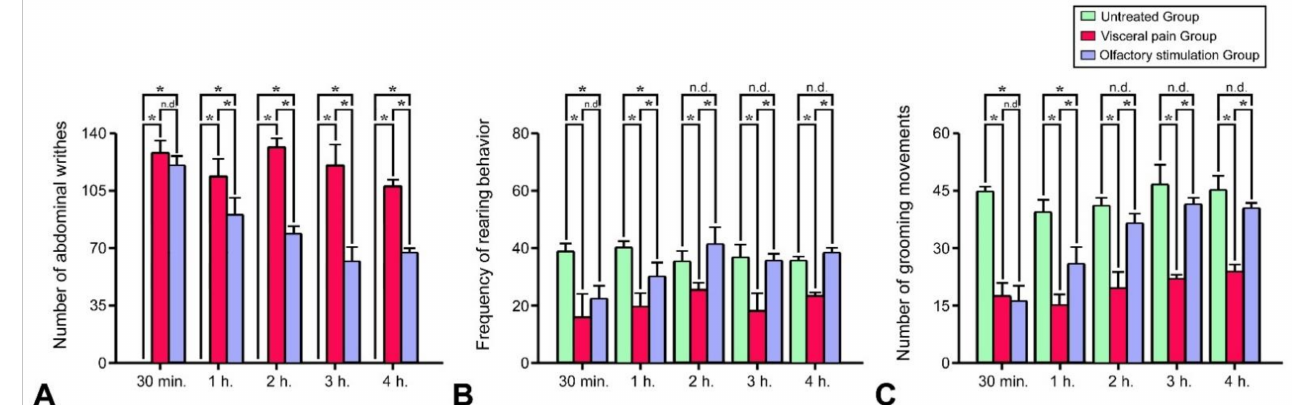
Figure 9. Histograms show the behavioral performances of the animals obtained from the untreated, visceral pain, and OS groups at several time points. Note that significant behavioral changes in- cluding the incidence of abdominal writhing ( A ) together with decreased rearing ( B ) and grooming movements ( C ) were detected in the animals subjected to visceral pain. However, in rats subjected to visceral pain and receiving OS for 1 h, both the incidence of abdominal writhing and the frequency of rearing and grooming behaviors were observed to be effectively improved. Also note that in animals subjected to visceral pain and received OS for 4 h, the behavioral performances were much better than that treated with OS for 1 to 3 h. * p < 0.05, n.d. = no significant